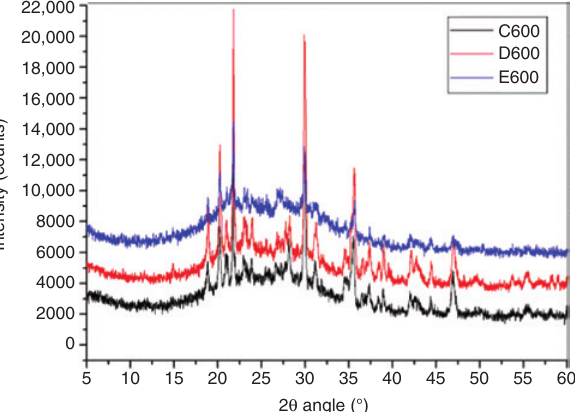
Figure 7: XRD pattern of C600, D600 and